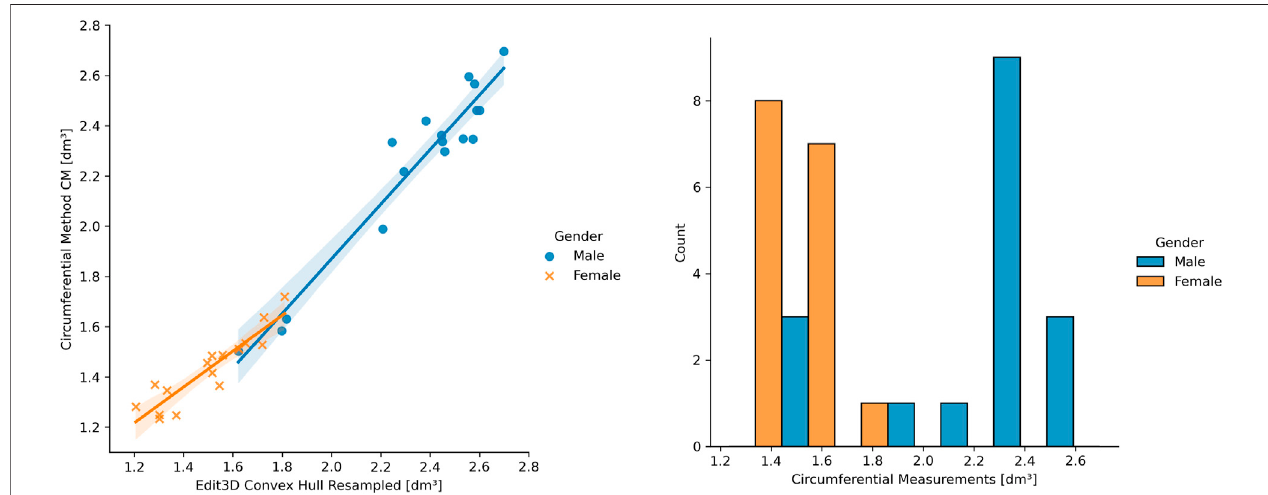
FIGURE 7 | On the left: example of gender differences in the upper limb volume clinical vs digital. On the right: ground-truth data distribution among genders.